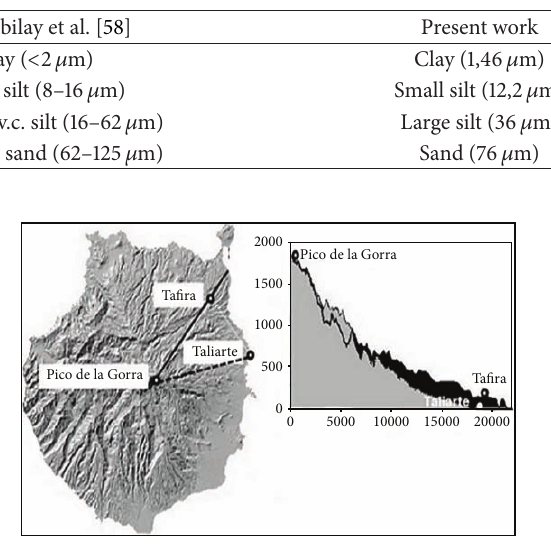
Figure 15: Location of the three sampling sites in Gran Canaria: Pico de la Gorra (1930 m a.s.l., 27 ∘ 56 󸀠 N, 15 ∘ 33 󸀠 W), Tafira (269 m a.s.l, 28 ∘ 06 󸀠 N, 15 ∘ 24 󸀠 W), and Taliarte (close to sea level; 27 ∘ 59.5 󸀠 N, 15 ∘ 22 󸀠 W)